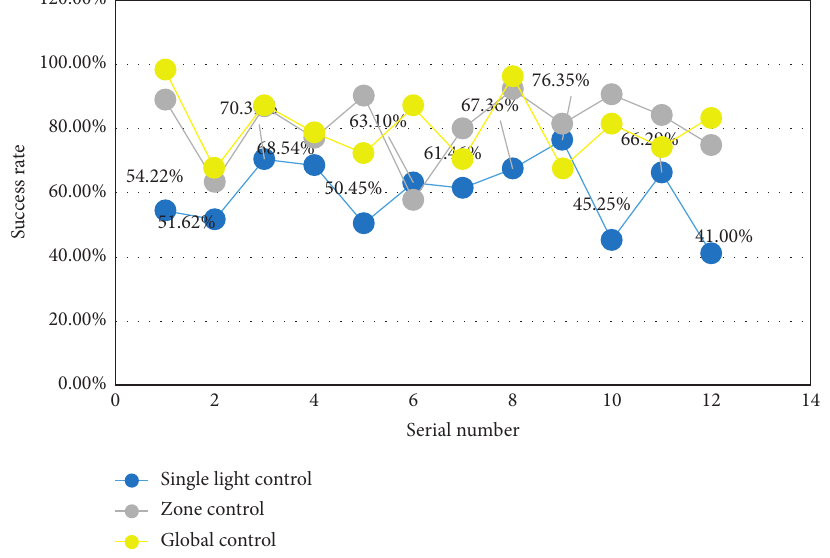
Figure 3: Temperature test results.